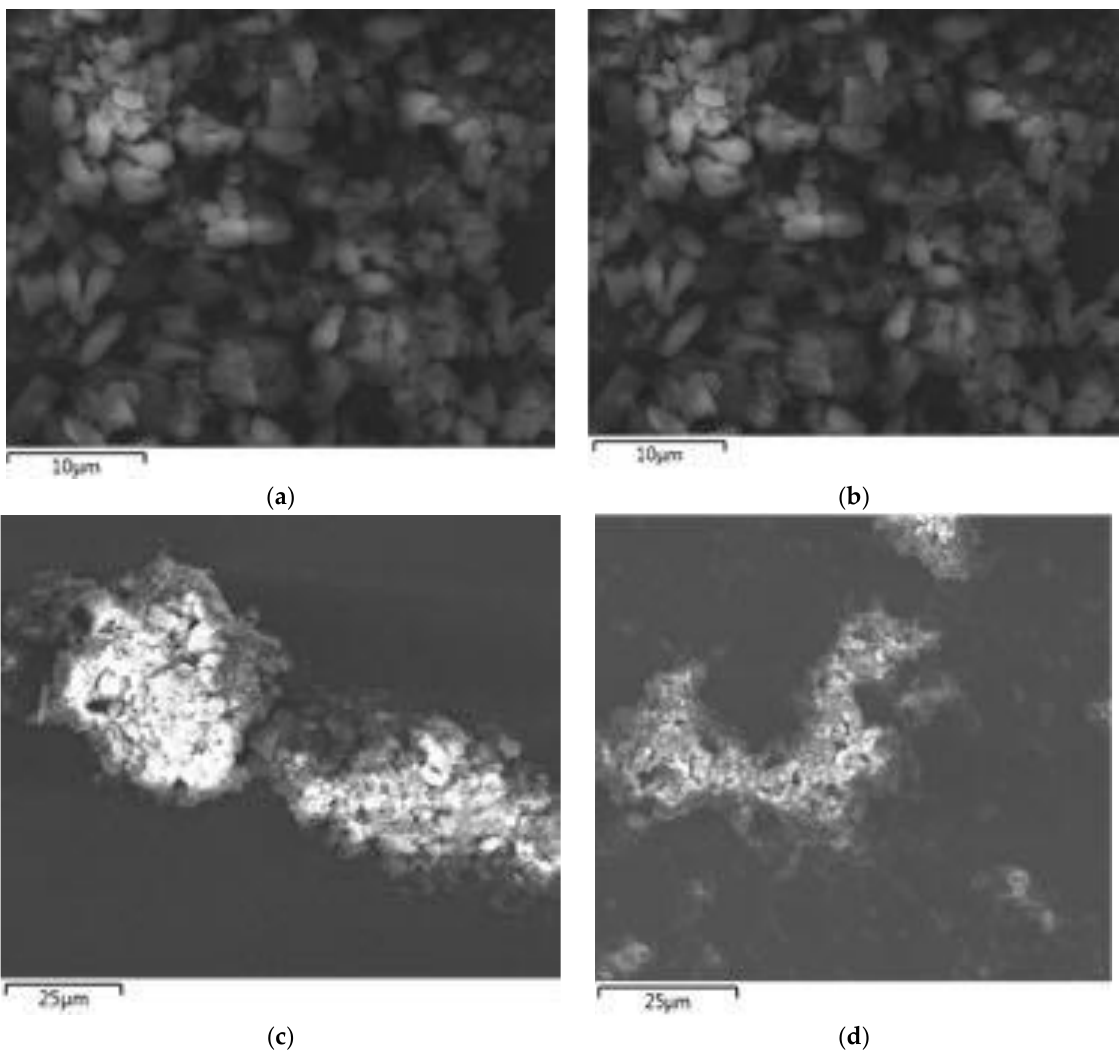
Figure 2. EDX images of ( a ) C 3 N 4 /ZnO — 0.1 g ( b ) C 3 N 4 /ZnO — 0.2 g ( c ) C 3 N 4 ZnO — 0.3 g ( d ) C 3 N 4 /ZnO — 0.4 g.